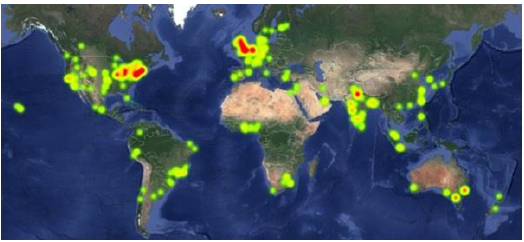
Figure 4. Geographical Distribution of BoP